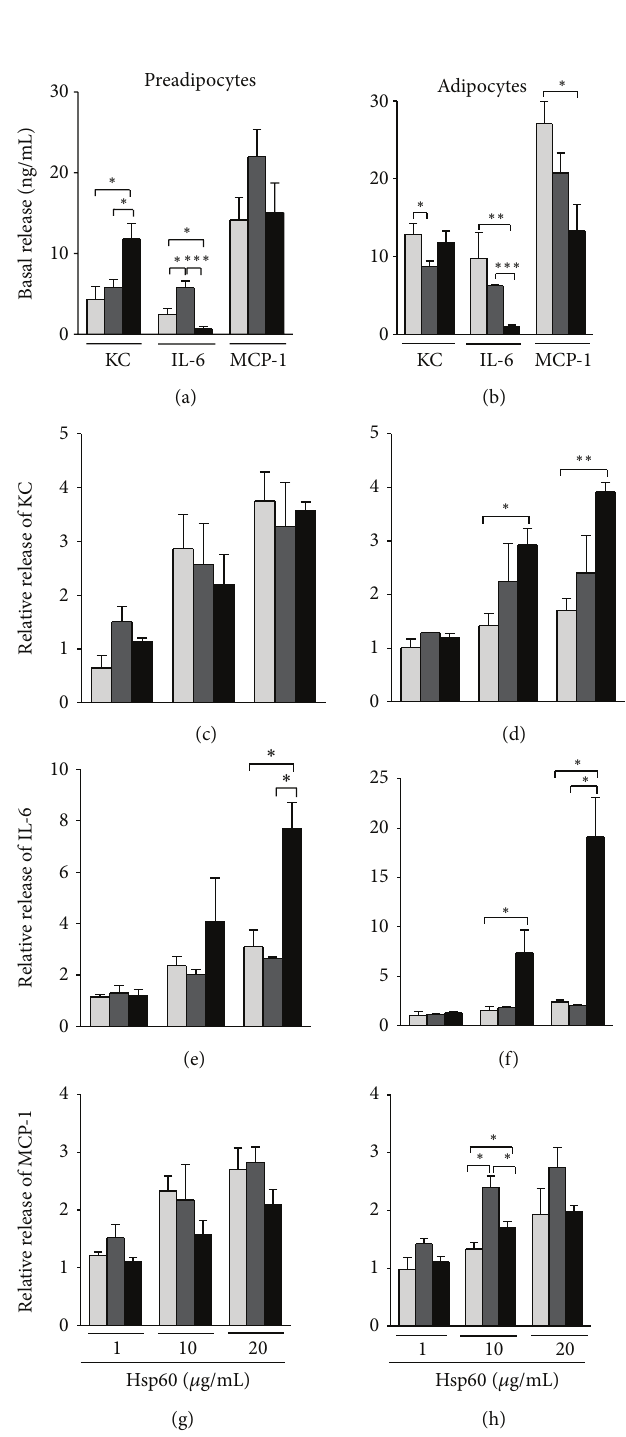
Figure 4: Hsp60-induced release of inflammatory mediators by (pre-)adipocytes from C57BL/6J, NOD, and NZO mice. (Pre-)adipocytes from C57BL/6J (light grey bars) NOD (dark grey bars), and NZO mice (black bars), were incubated in the absence (a, b) or presence (c–h) of increasing concentrations of Hsp60 (1–20 𝜇 g/mL) and the accumulation of KC, IL-6, and MCP-1 in the culture supernatants was analyzed by multiplex-beads-assay after 24h. The results show concentrations of accumulated cytokines (a, b) or of cytokine release relative to the cytokine levels detected in the supernatants of unstimulated cells (c–h). The data represent means + SEM of three independent experiments, each performed in triplicates. ∗ 𝑃 < 0.05 , ∗∗ 𝑃 < 0.01 , ∗∗∗ 𝑃 < 0.001 compared to other mouse